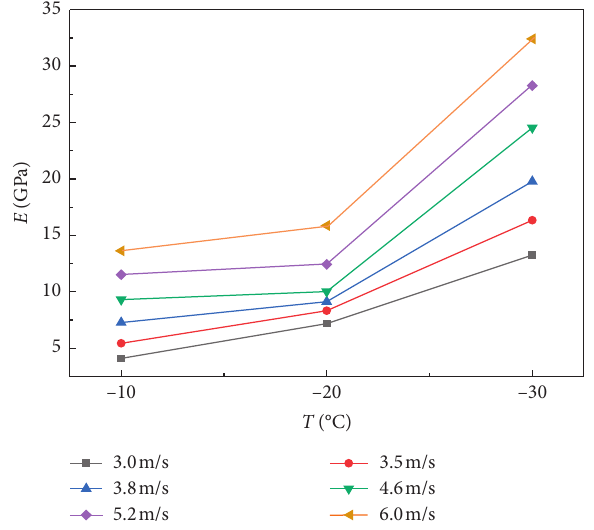
Figure 5: Dynamic elastic modulus of sandstone at different